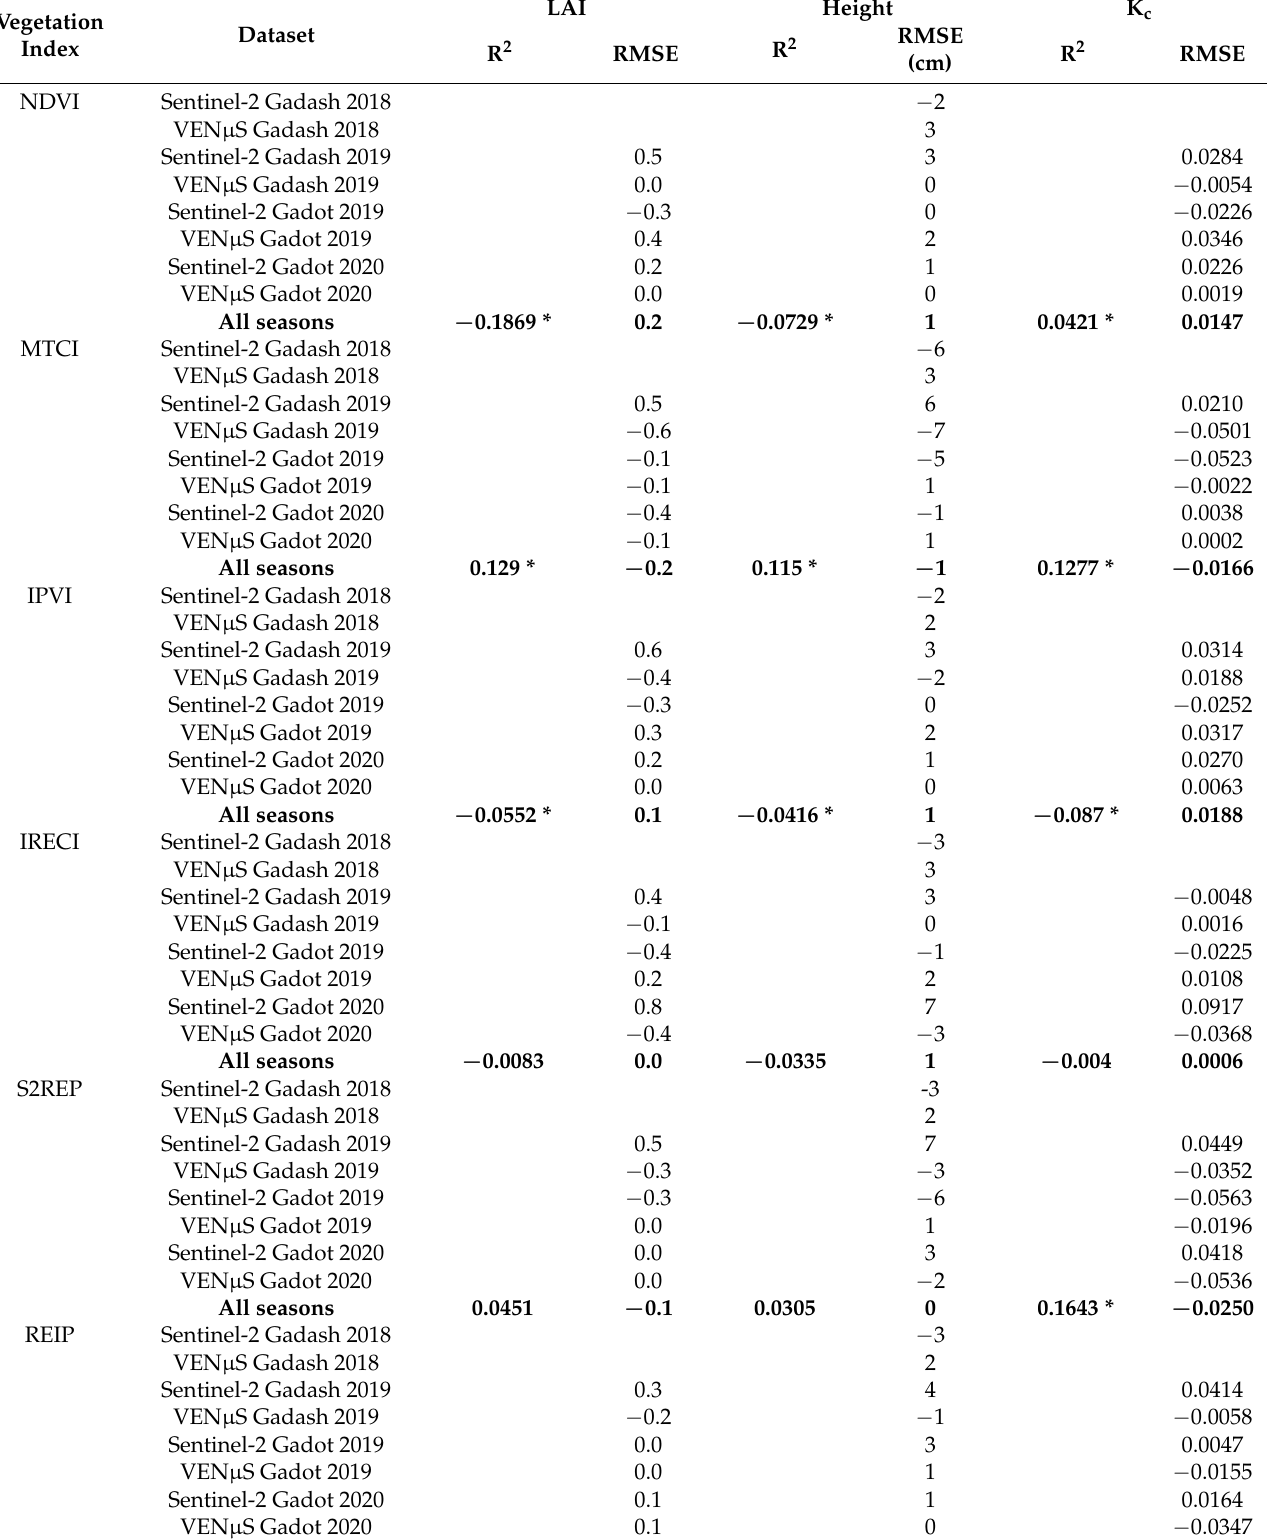
Table A5. Difference between performance statistics of S2/V T and S2/V NT -based LAI, Height, K c models. If R 2 is positive and RMSE is negative, it means that this parameter performance of the combined S2/V T model is higher than the equal parameter of the S2/V NT model. Significant differences are marked with (*). Performance statistics of better performing VIs can be found in Table